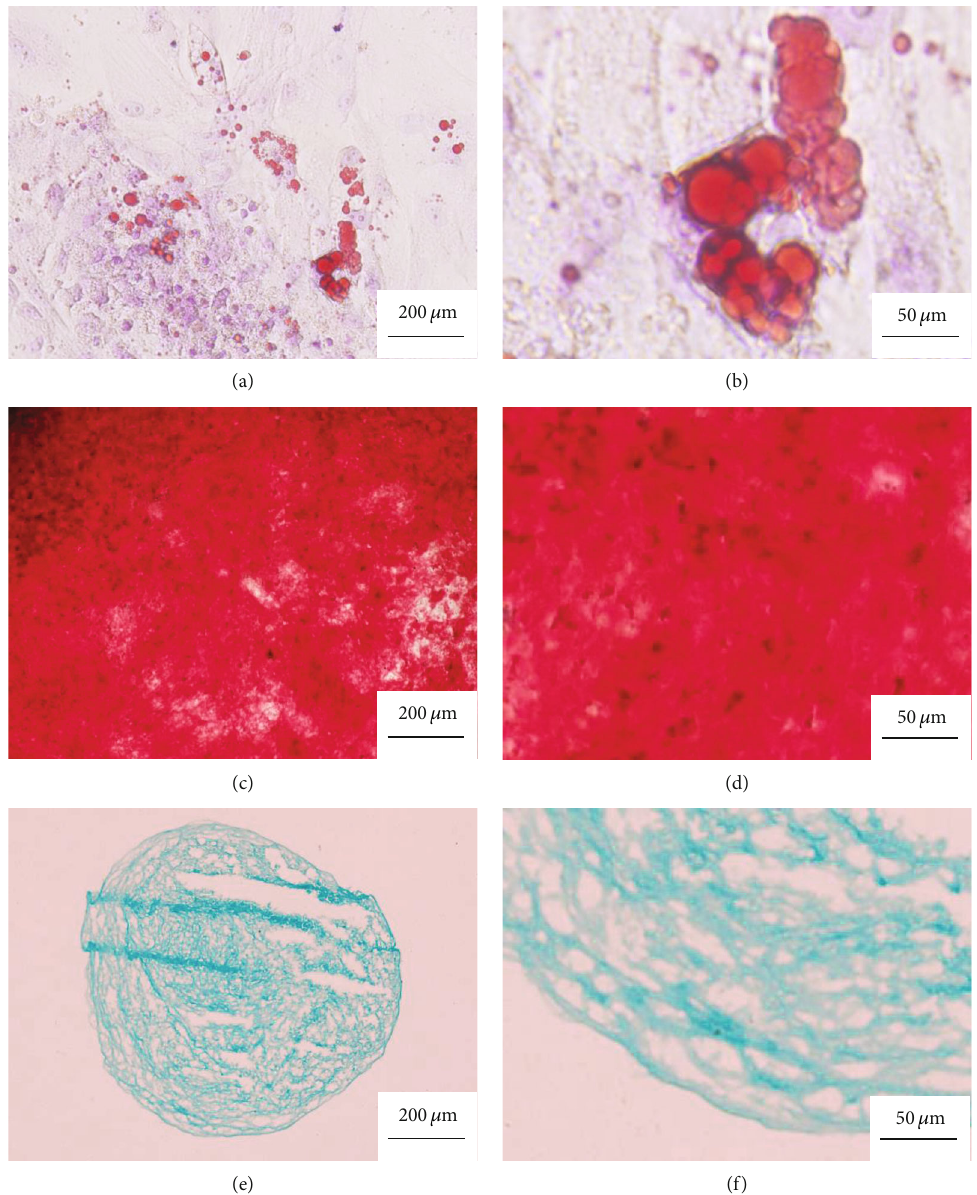
Figure 3: The three-way di ff erentiation and staining results of IPFP-MSCs isolated from three rabbits. (a, b) After staining with Oil red O for adipogenic di ff erentiation, red lipid droplets fused into pieces can be seen. (c, d) After staining with Alizarin red for osteogenic di ff erentiation, there were red calcium nodules fused into masses. (e, f) After staining with Alcian blue for chondrogenic di ff erentiation, a large amount of blue-stained acid mucopolysaccharide appears among the